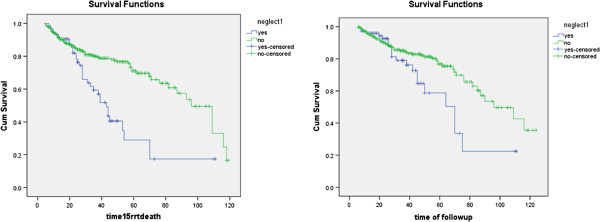
Kaplan-Meier estimated survival curves. Patients who were under medical supervision (n=389) showed a higher survival and longer time to achieve a eGFR of less than 15 cc/min compared with those who were not under medical observation (n=76) (34 vs 84months), according to the Log Rank test significance level (p<0.0001). Supervised patients also had less need for RRT and less death compared with controls (20 vs. 67months) (P = 0.029)